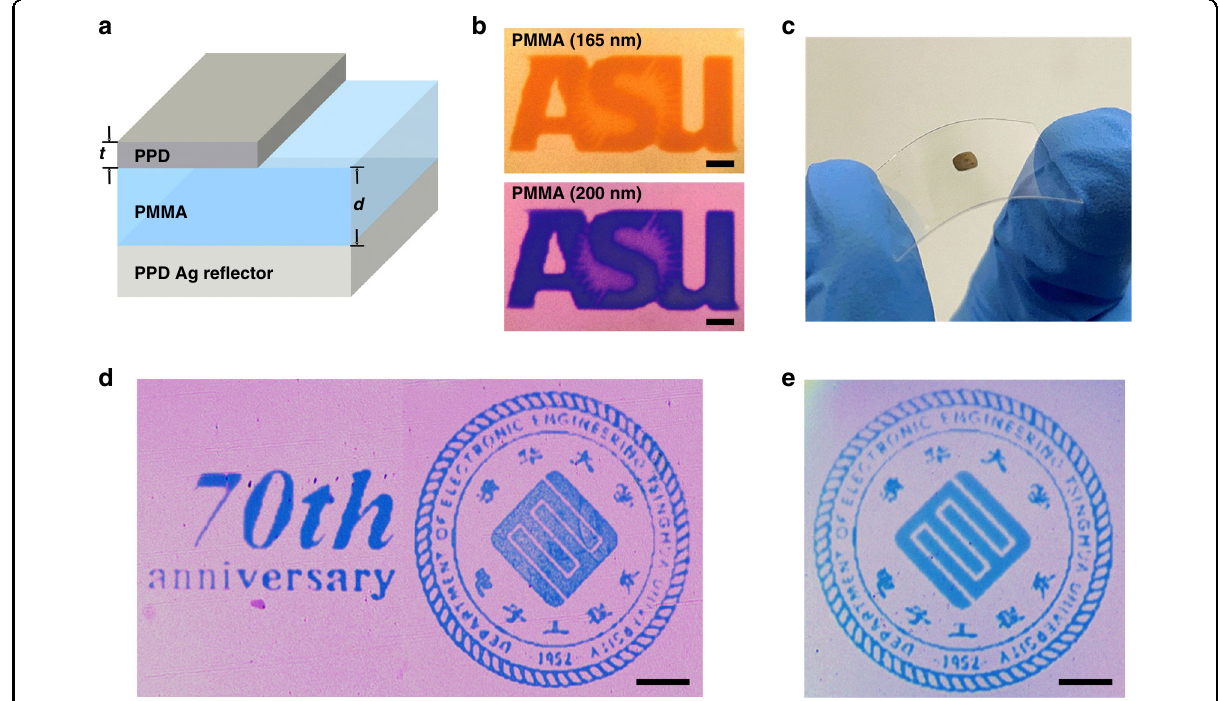
Fig. 6 Photolithography and vacuum-free structural color printing. a Three-dimensional schematic of the FP cavity. b An exhibited colored ASU logo on the dielectric-coated metallic layer with various PMMA thicknesses using fused silica as a substrate. Scale bar: 50 μ m. c Camera image of fabricated FP cavity on PET substrate with slight bending capability. d , e Optical images of produced colored DEETHU logo on the dielectric-coated metallic layer using PET and PDMS as substrates, respectively. Scale bar: 100 μ